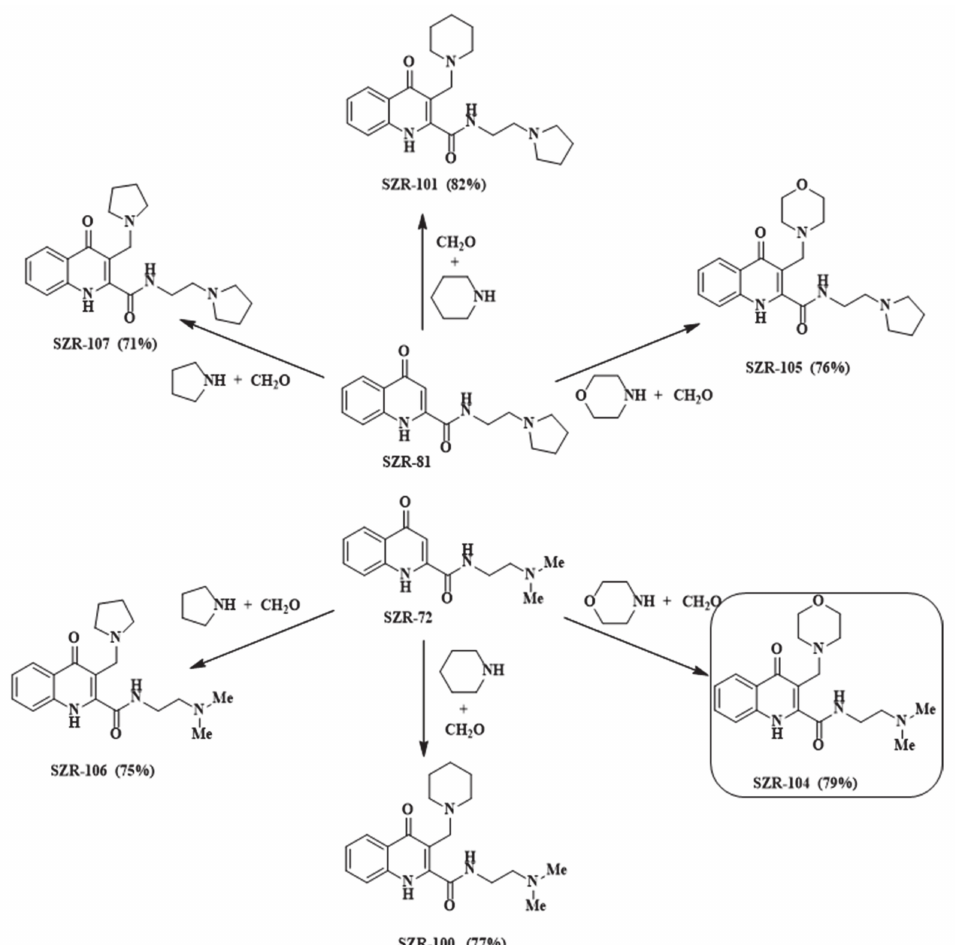
Figure 2. Synthesis of aminoalkylated KYNA amide